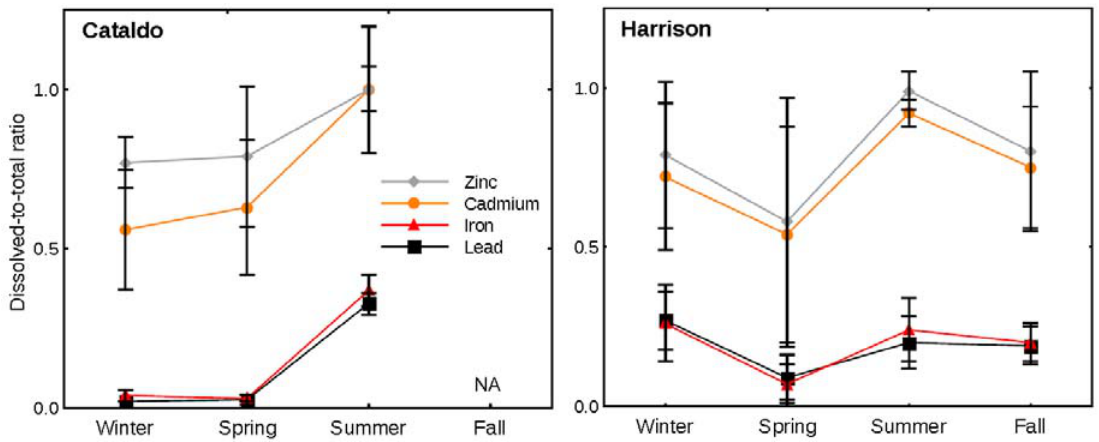
Figure 4. Median ratio and absolute deviation of dissolved-to-total concentration ratios of metals in streamflow at the Cataldo (upper basin) and Harrison (lower basin) sites, 2005–2015.